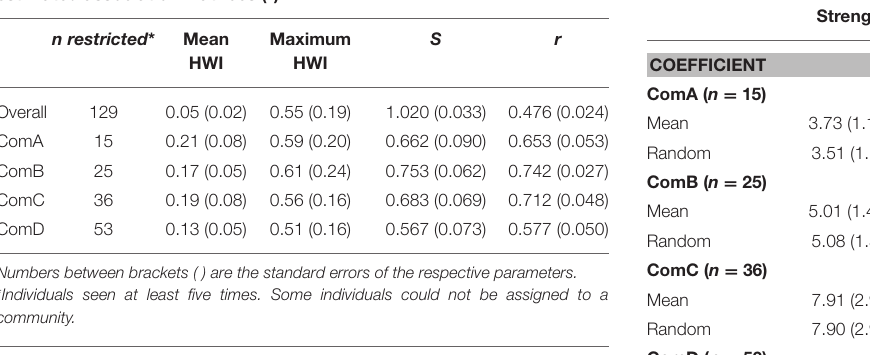
TABLE 2 | The mean association indices for the population overall and per community (ComA, ComB, ComC, and ComD); the measure of social differentiation ( S ); and the correlation coefficient of the true and estimated association matrices ( r ).